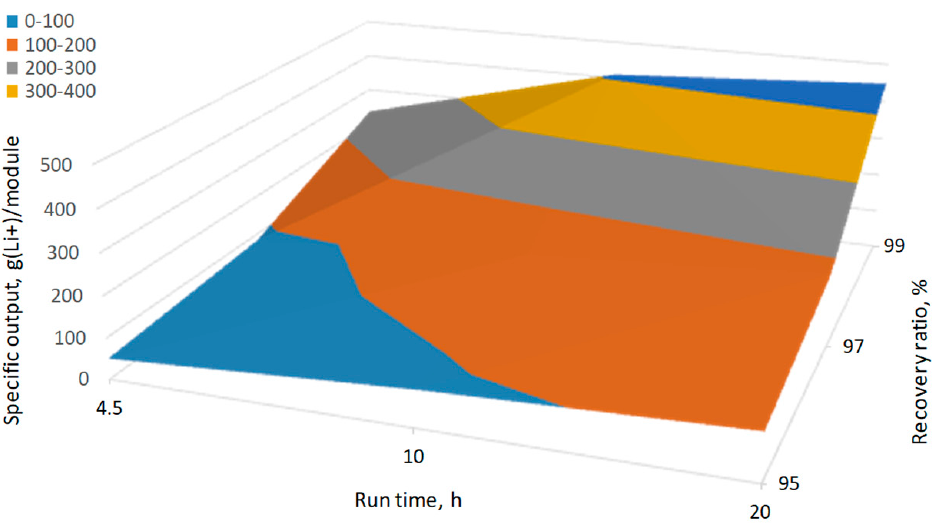
Figure 8. Effect of run time Rt and recovery ratio RR on lithium recovery per membrane module. Table 6. Effect of membrane performance threshold MPT on process parameters (two months of operation). Simu-